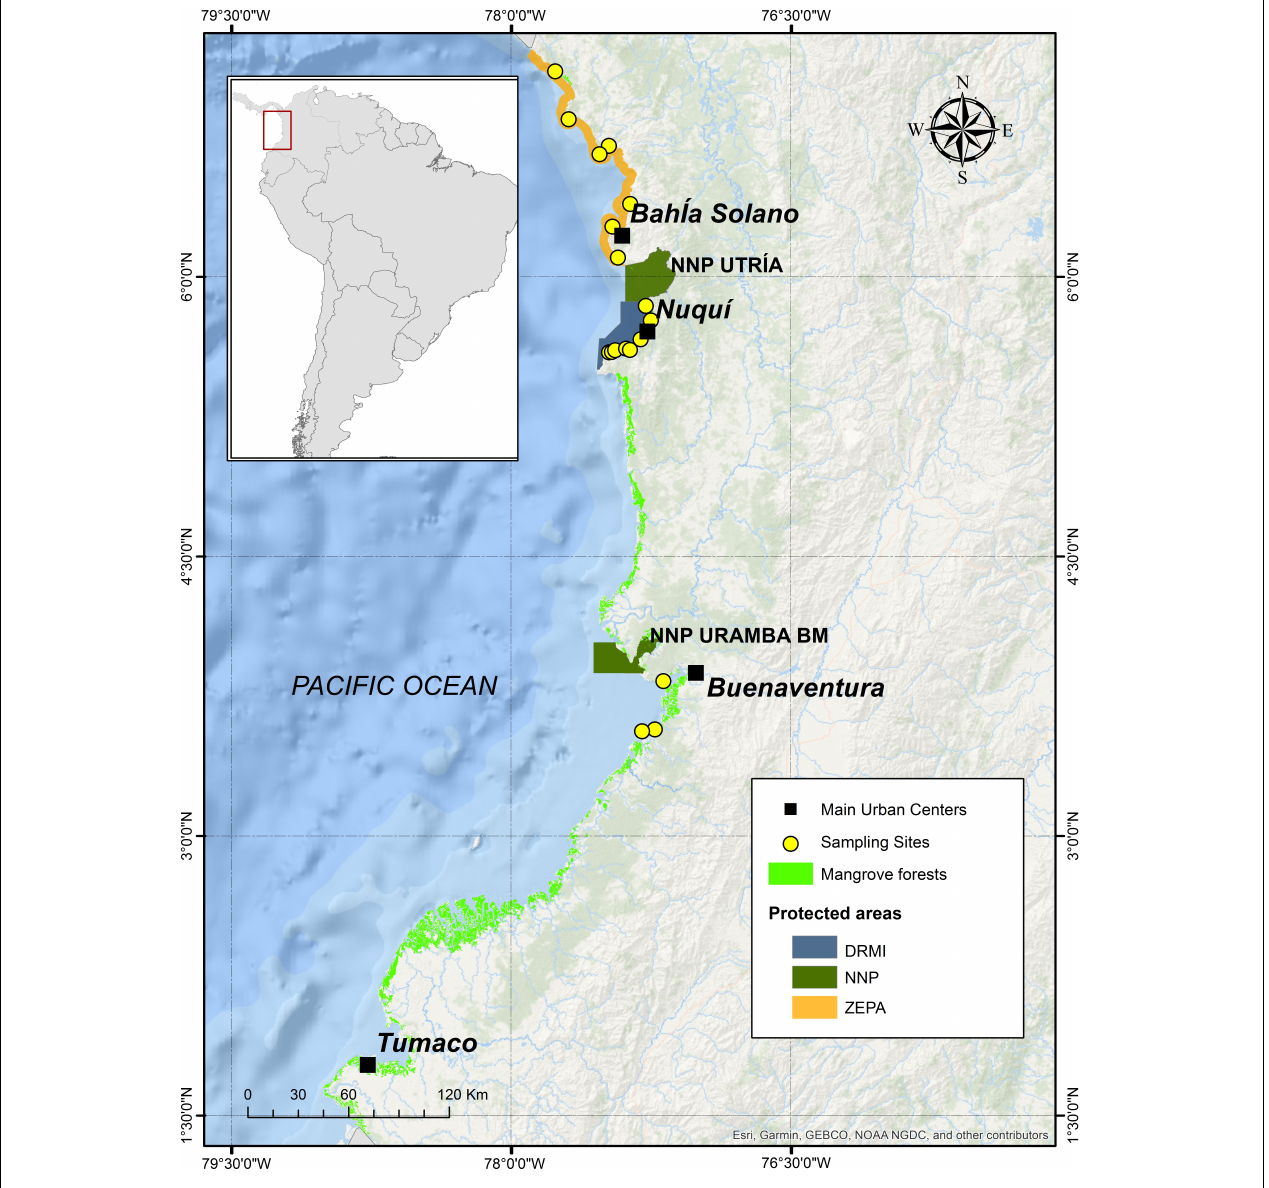
FIGURE 1 | Colombian Pacific coast with location of the three coastal zones included in this study: ZEPA, Tribugá (DRMI + National Natural Park Utría) and Buenaventura. Location of sampled landing sites, National Natural Parks and mangrove forests within the three coastal zones are also shown.